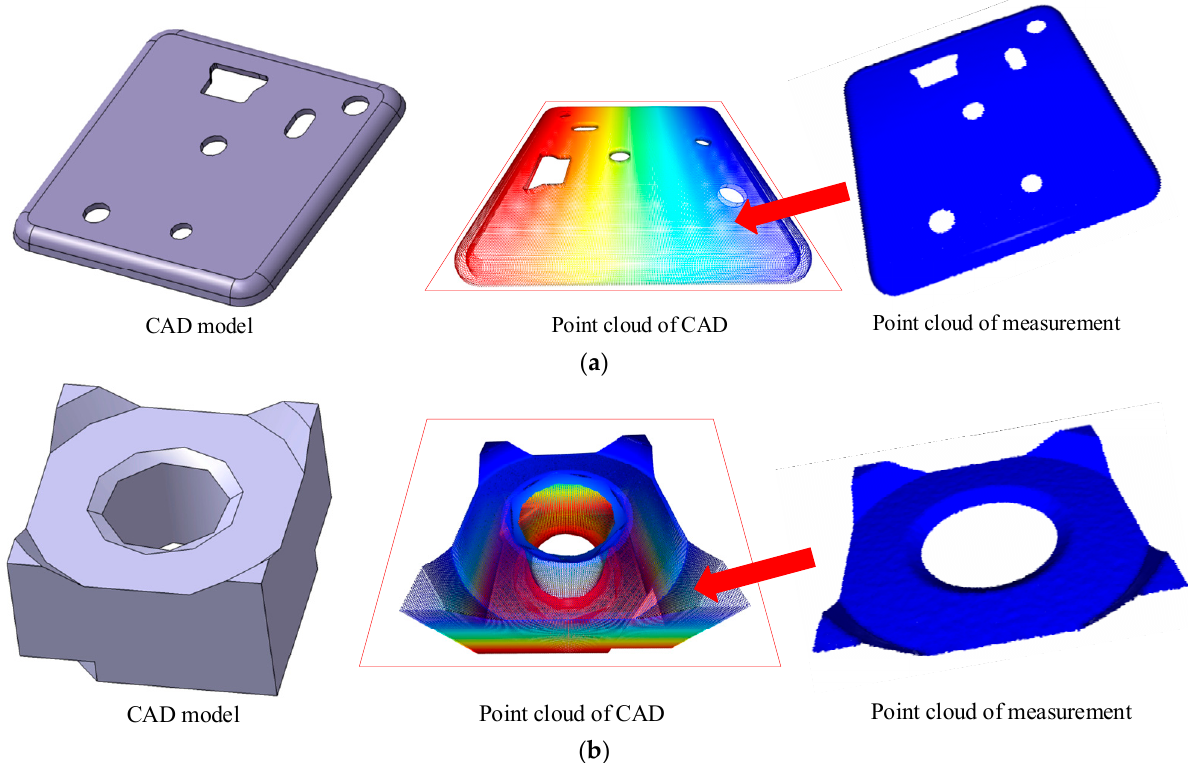
Figure 13. ( a ) Digital model point cloud and a measurement point cloud of part 1; ( b ) Digital model point cloud and a measurement point cloud of part 2.